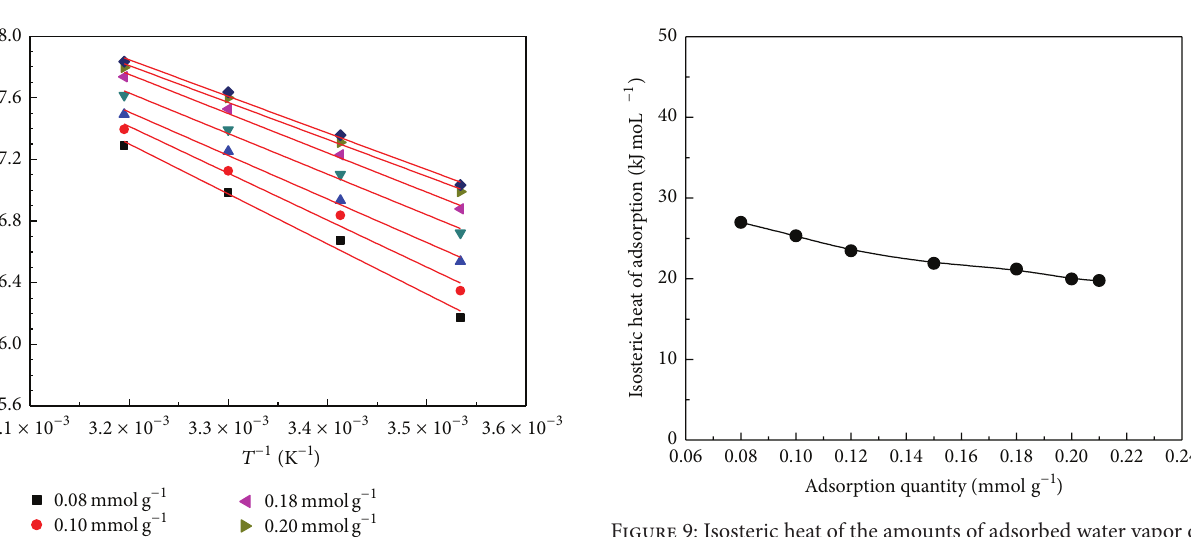
Figure 9: Isosteric heat of the amounts of adsorbed water vapor on the